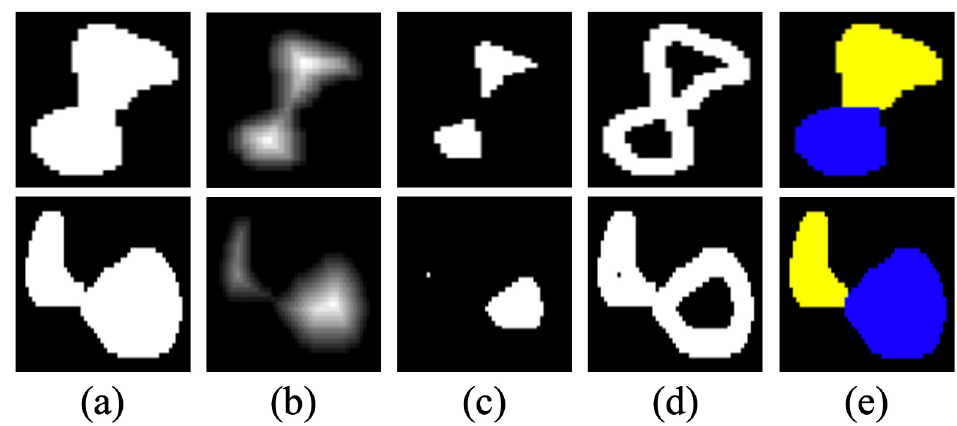
Fig 4. A demonstration of the distance-based watershed cell segmentation. A: Initial cell segmentation. B: Distance transform. C: Identified cell instance regions; D: Unknown region to be assigned. E: Final cell segmentation results.